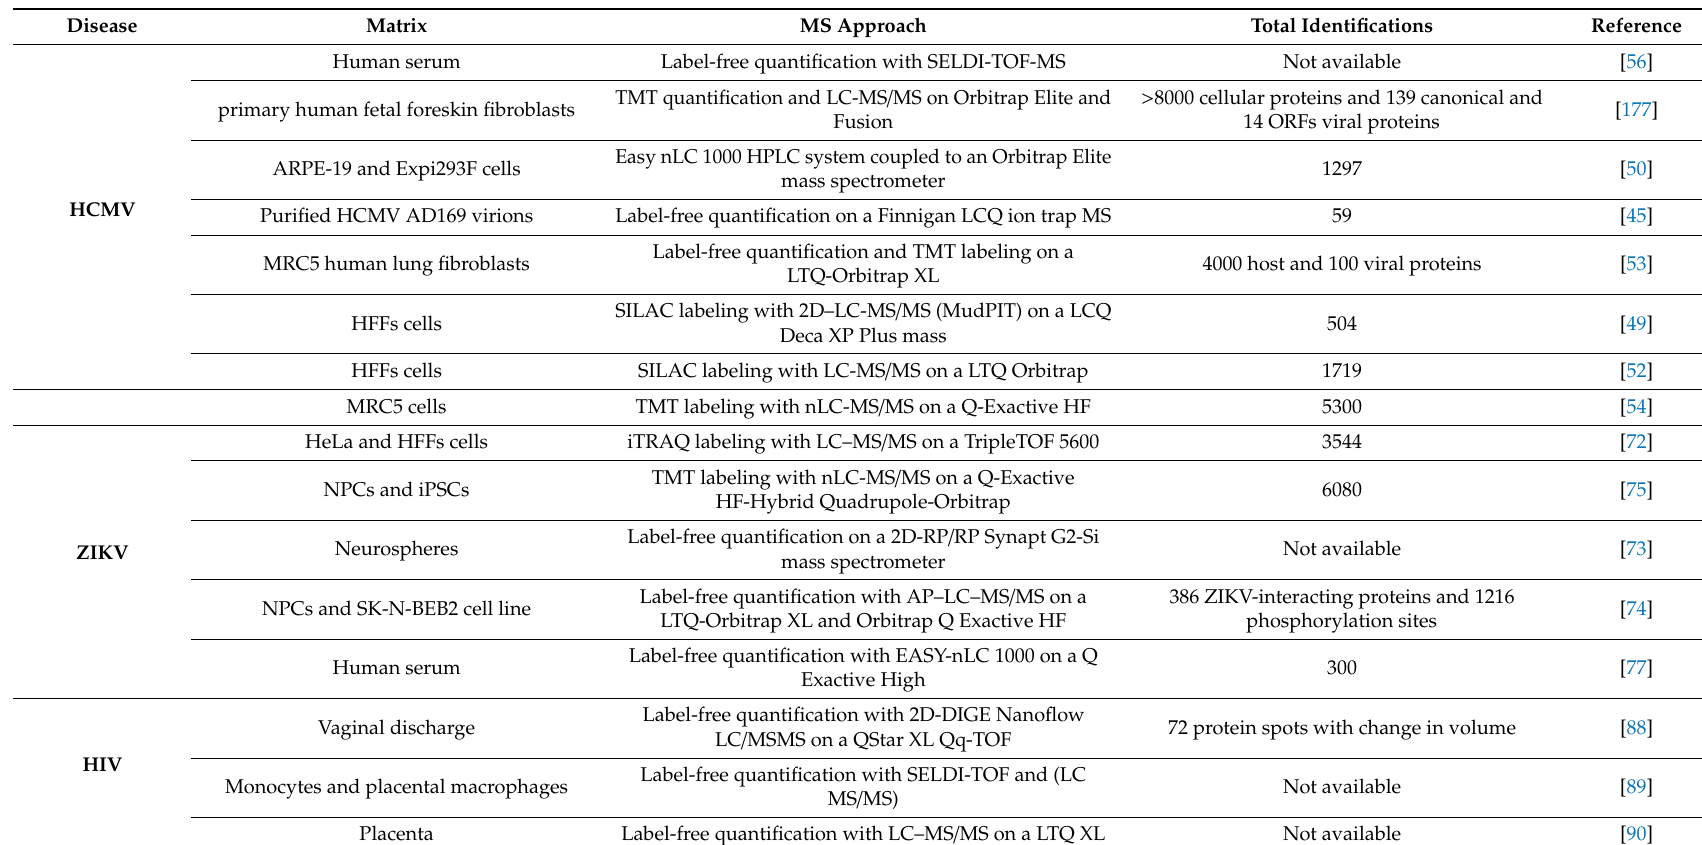
Table 2. Representative proteomics-driven studies on TORCH associated infections. Examples on biological matrices analyzed, the proteomic strategy and the number of total protein identifications are